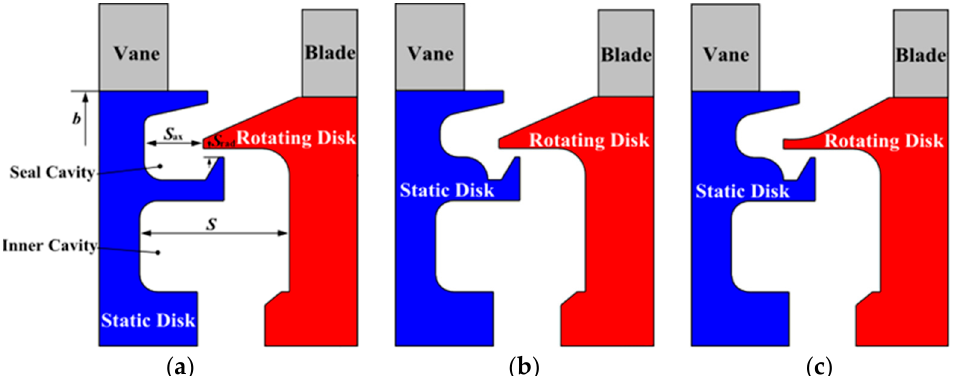
Figure 2. Meridional structural configuration of the turbine rim seals. ( a ) Seal-A; ( b ) Seal-B; and ( c ) Seal-C.